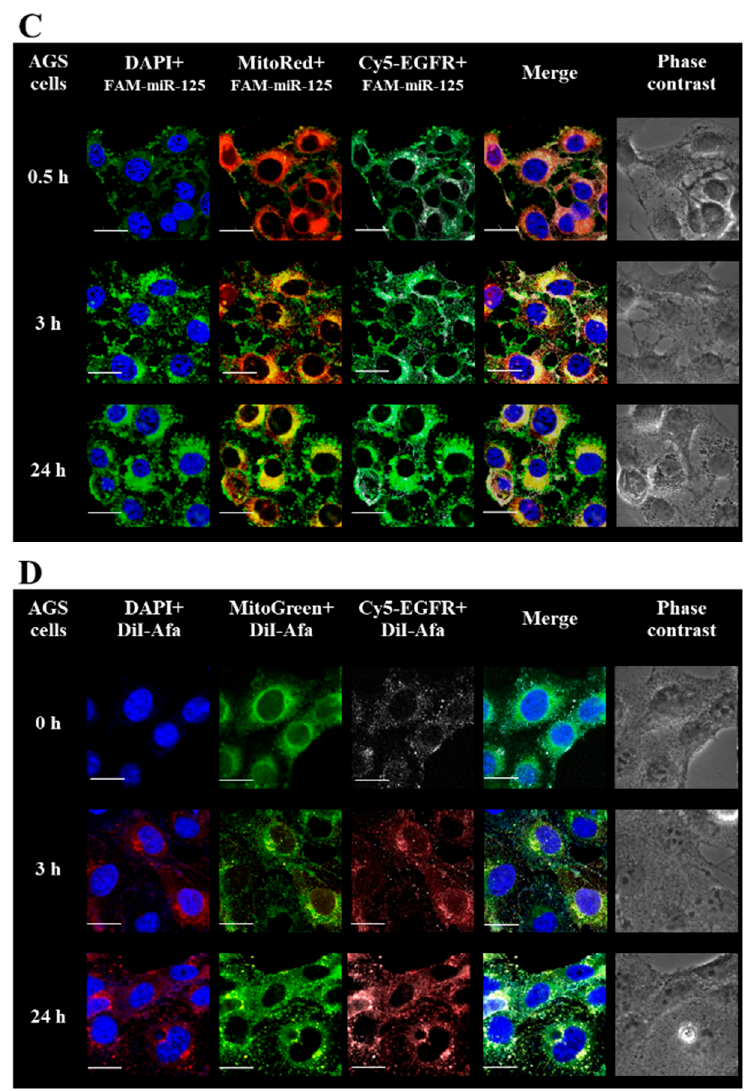
Figure 2. Cytotoxicity, cellular uptake, and intracellular trafficking of different Afa and/or miR-125 formulations. ( A ) Cytotoxicity of Afa and/or miR-125 formulations on ( left ) AGS cells and ( right ) IEC-6 cells for 48 h at IC30 dose of Afa (300 nM). Cell viability was determined by sulforhodamine B (SRB) assay (NS, not significant; statistical significance at * p < 0.05; ** p < 0.01; *** p < 0.001). ( B ) Measurement of intracellular intensity of ( left ) FAM-miR-125 (100 nM) and ( right ) DiI-Afa (100 ng/mL) in various formulations for 24 h in AGS cells by flow cytometry. ( C ) Intracellular trafficking of FAM-miR-125 + Afa/SLN-KL in AGS cells for 0/0.5, 3, and 24 h. FAM-miR-125: 100 nM; Afa: 300 nM. Blue: DAPI (a nuclear dye); red: MitoRed (a mitochondrial dye); green: FAM-miR-125 (a fluorescent miR-125); gray: Cy5-Anti-EGFR. Scale Bar, 20 µ m. ( D ) Intracellular trafficking of miR-125 + DiI/SLN-KL in AGS cells for 3, 8, and 24 h. MiR-125: 100 nM; DiI: 100 ng/mL. Blue: DAPI (a nuclear dye); green: MitoGreen (a mitochondrial dye); red: DiI (a probe of Afa); gray: Cy5-Anti-EGFR. Scale bar, 20 µ